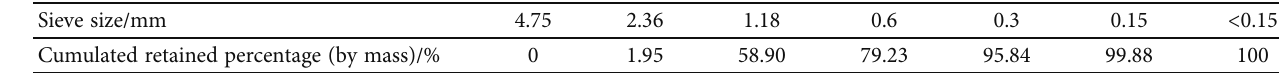
Table 1: Coral sand particle size distribution.